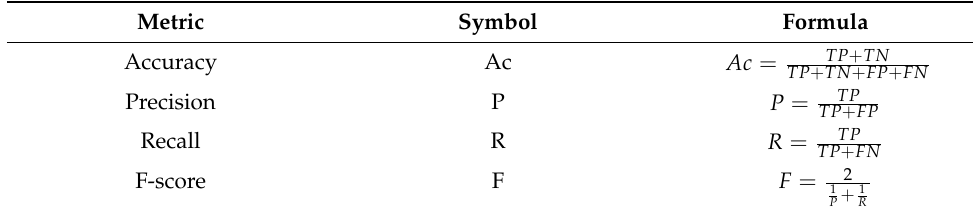
Table 1. Traditional performance